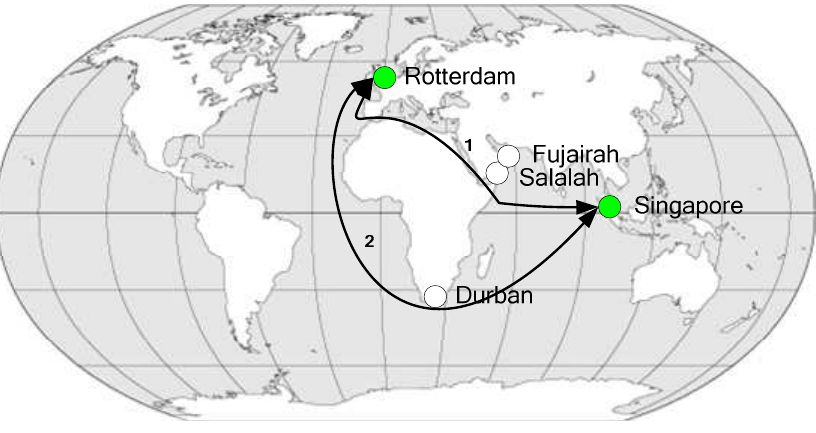
Figure 1. Shipping routes of vessels sailing between Rotterdam and Singapore. The dots indicate ports that could be serious competitors for